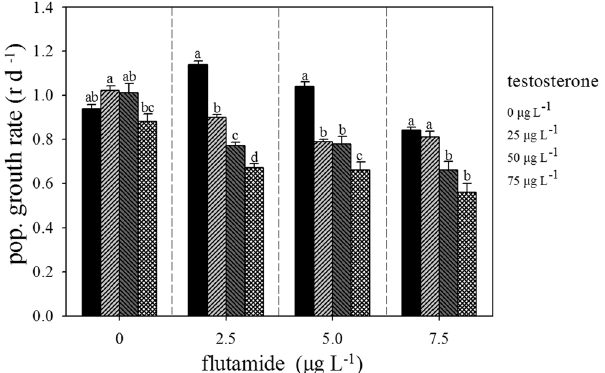
Figure 1. Effects of testosterone and flutamide on the population growth rate (r) in Brachionus calyciflorus (n = 5).